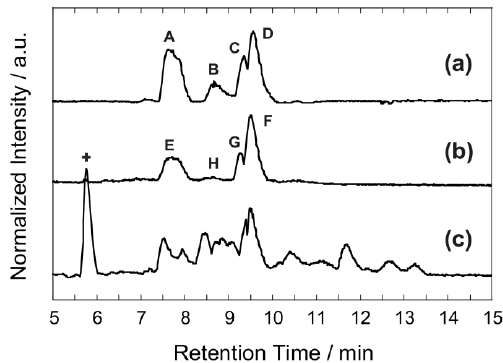
Figure 4. Mass chromatograms for the products of the formose reaction carried out using 1 M formaldehyde and 120 mM calcium hydroxide at 60 °C in the presence of 10 g·L −1 pDMA/VBA ( a ) and 0.5 mM PBA ( b ), and in their absence ( c ). The reaction time was 180 ( a , b ) or 20 min ( c ). The m / z range of 60–250 was detected.